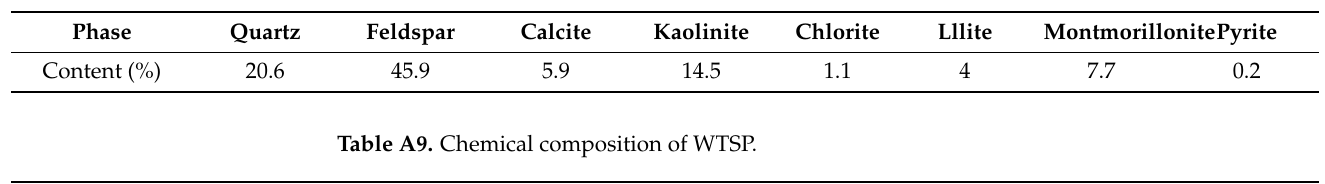
Table A8. Phase analysis of WTSP.